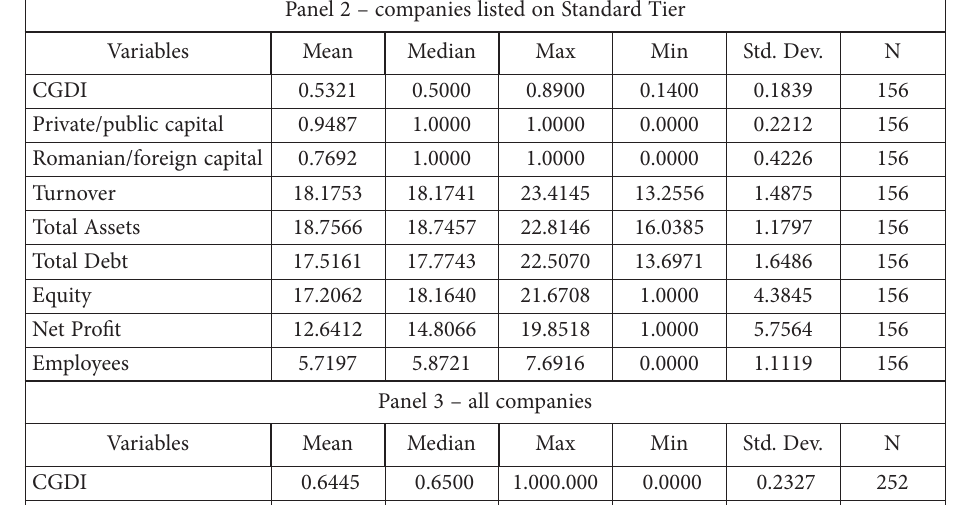
Panel 2 – companies listed on Standard